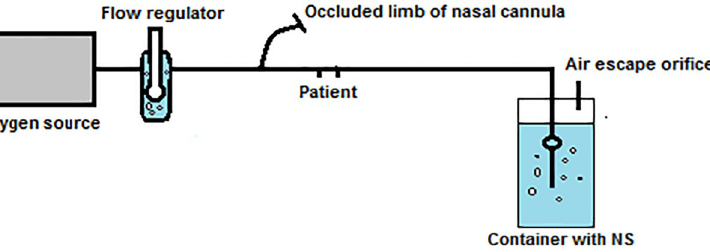
Fig 1. A simplified neonatal BCPAP circuit. BCPAP, bubble continuous positive airway pressure; NS, Normal